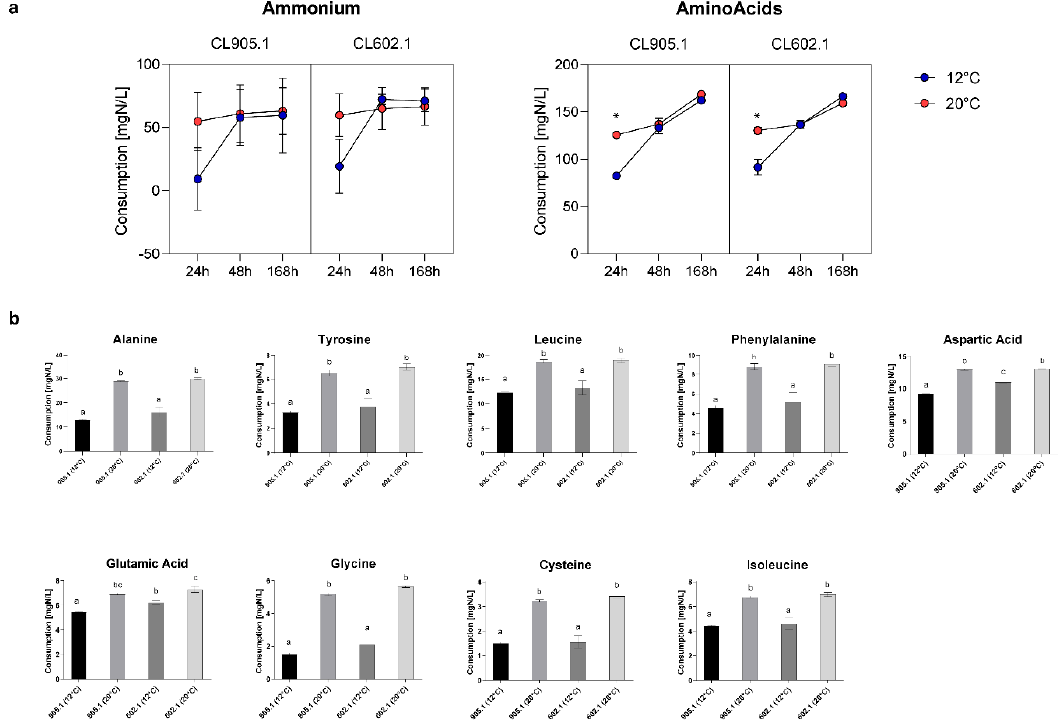
Figure 6. Differential yeast assimilable nitrogen (YAN) consumption in CL905.1 and CL602.1 strains at 12 °C and 20 °C. ( a ) Ammonium and amino acid consumption kinetics at 24, 48, and 168 h. Blue dots: 12 °C fermentation; Red dots: 20 °C fermentation. (*) depict significant differences between temperatures with a p -value < 0.001, one-way ANOVA. ( b ) Main differences in amino Acid consumption between temperatures. Different letters depict significant differences between strains with a p -value < 0.05, one-way ANOVA.